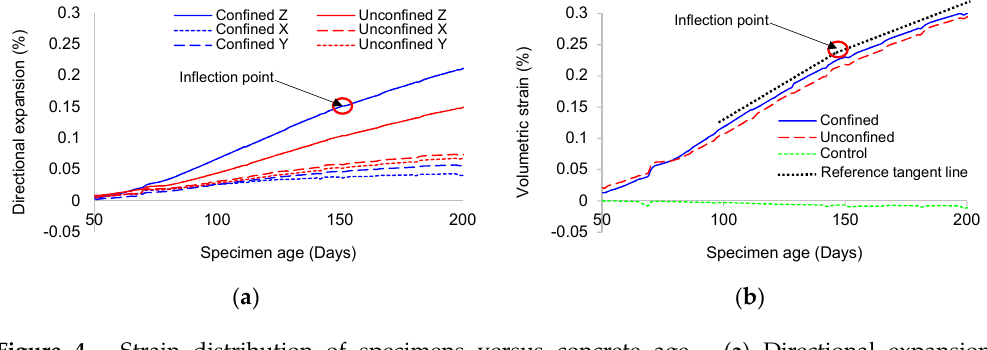
Figure 4. Strain distribution of specimens versus concrete age. ( a ) Directional expansion; ( b ) Volumetric strain.